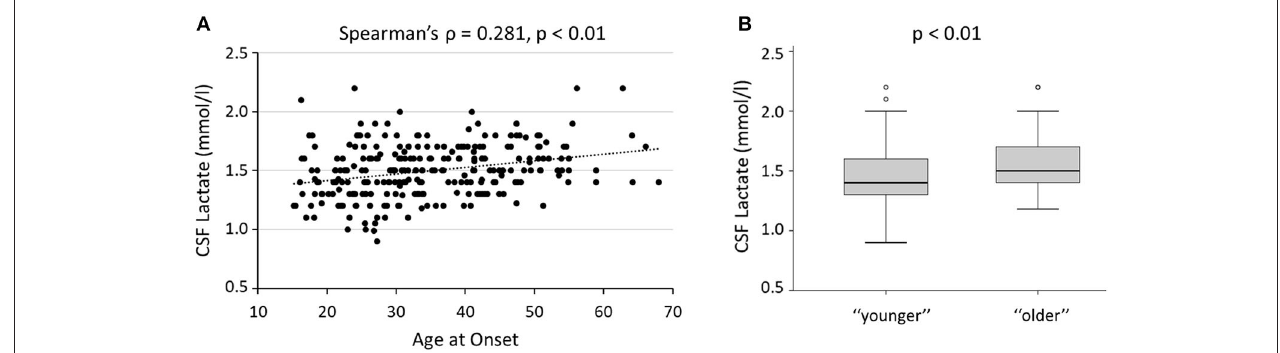
FIGURE 2 | Age and CSF lactate. (A) Correlation between age at onset and CSF lactate levels; Spearman’s ρ and B–H adjusted p -value are shown. (B) CSF lactate in “younger” and “older” patients with MS; the B–H adjusted p -value of the Mann–Whitney U test is shown. B–H, Benjamini–Hochberg; CSF, cerebrospinal fluid.